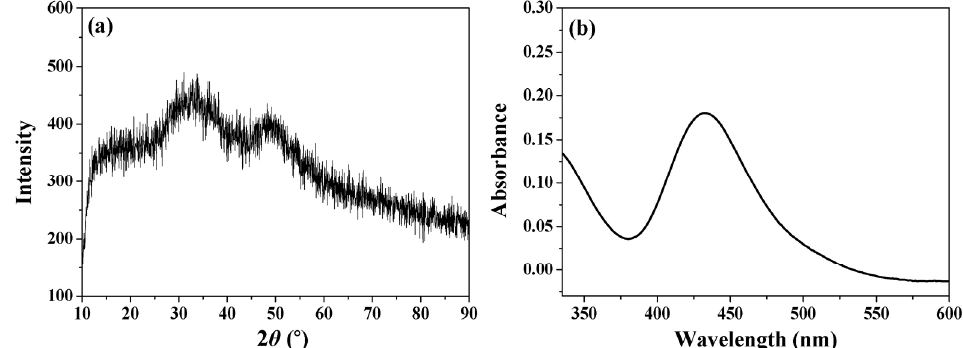
Fig. 3 XRD pattern and UV–vis absorption spectrum of water-soluble Cu